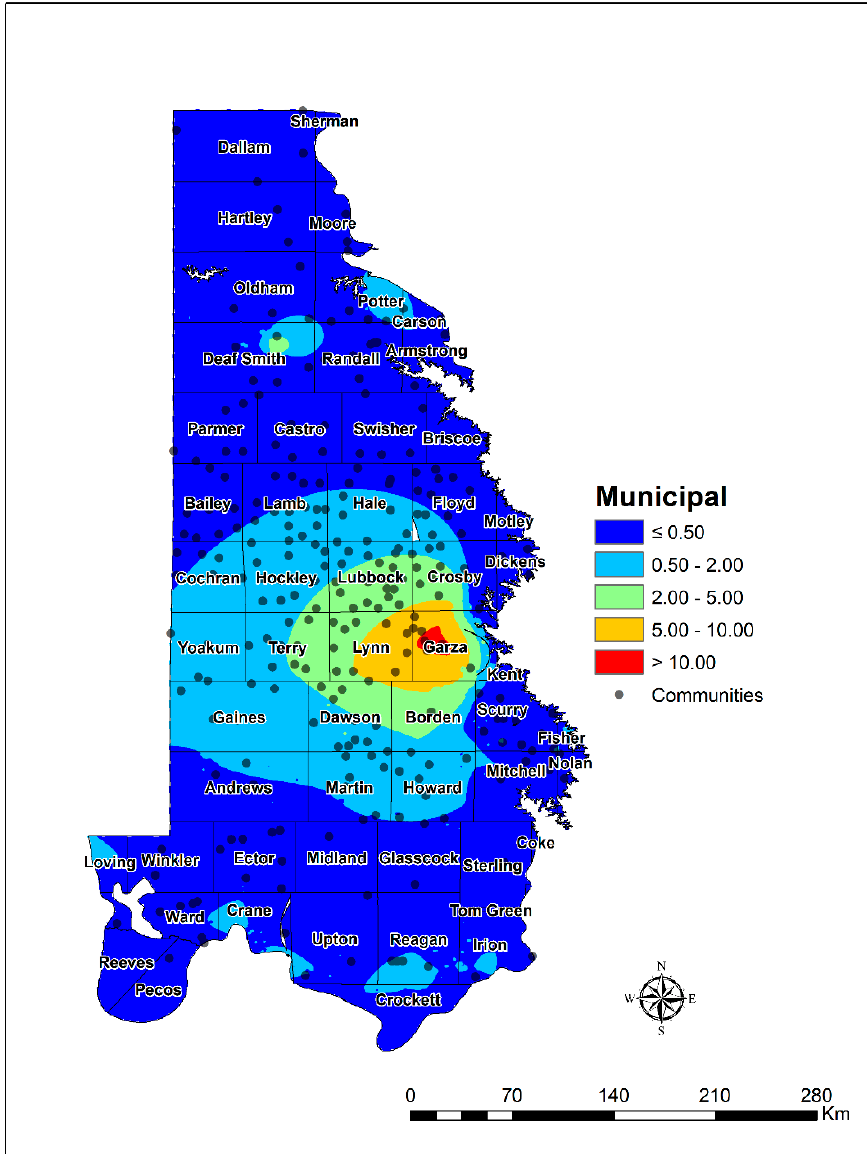
Figure 5. Overall Compatibility Index (OCI) for municipal water use.